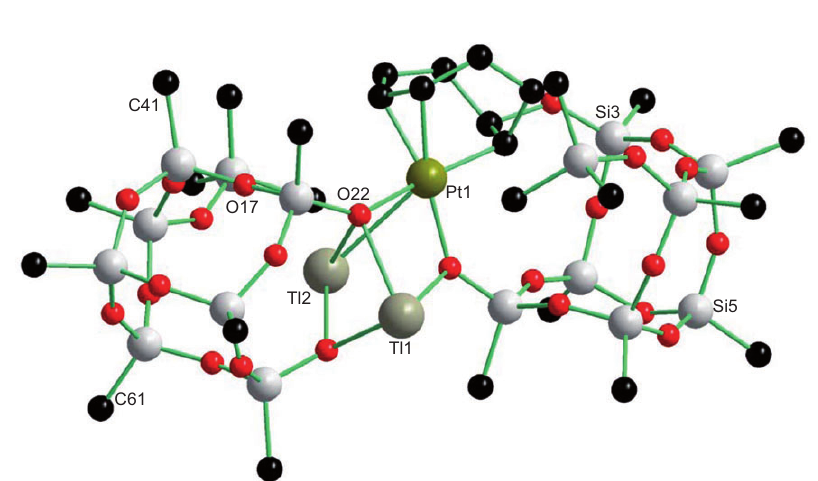
Figure 7 Structure of [(cod)Pt( μ -sqo)Tl Cyclopentyl groups were omitted for